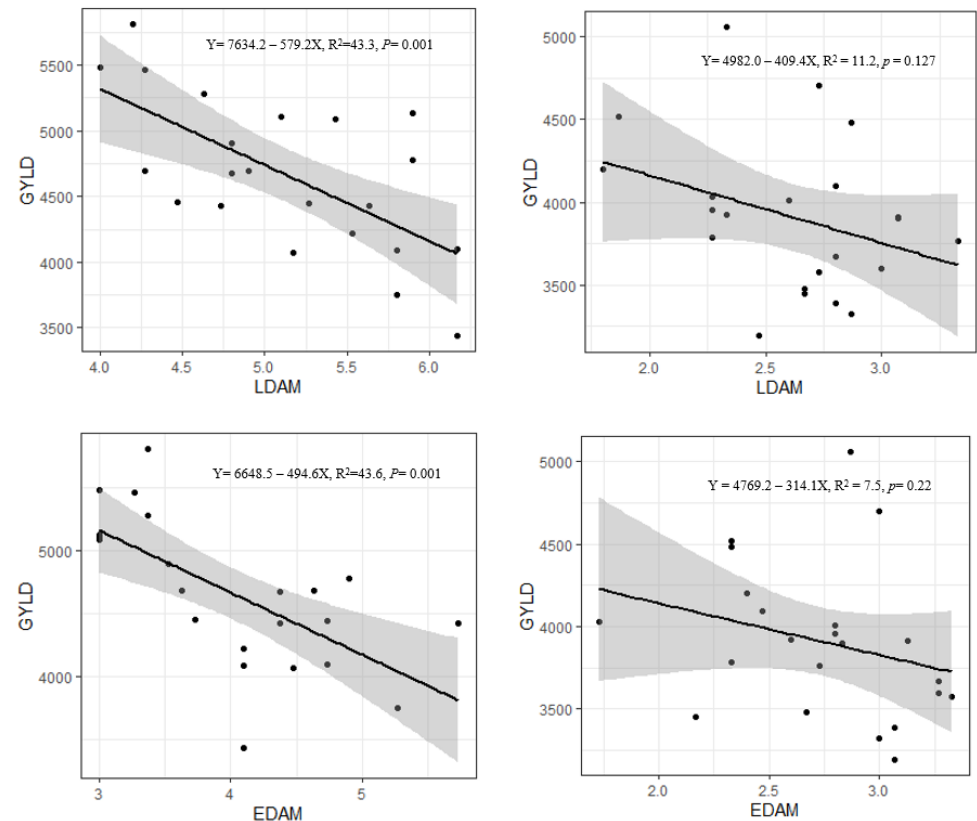
Figure 3. Scatterplots of the regressions of leaf damage (LDAM) and ear damage (EDAM) scores on grain yield (GYLD) of maize hybrids evaluated under artificial and natural fall armyworm infestations in Nigeria. Table 7. Pearson’s correlation coefficients for grain yield, agronomic and fall armyworm (FAW)- resistant traits of maize hybrids evaluated under FAW artificial infestation (Top diagonal), natural infestation (middle diagonal) and pesticide-protected conditions (bottom diagonal) in